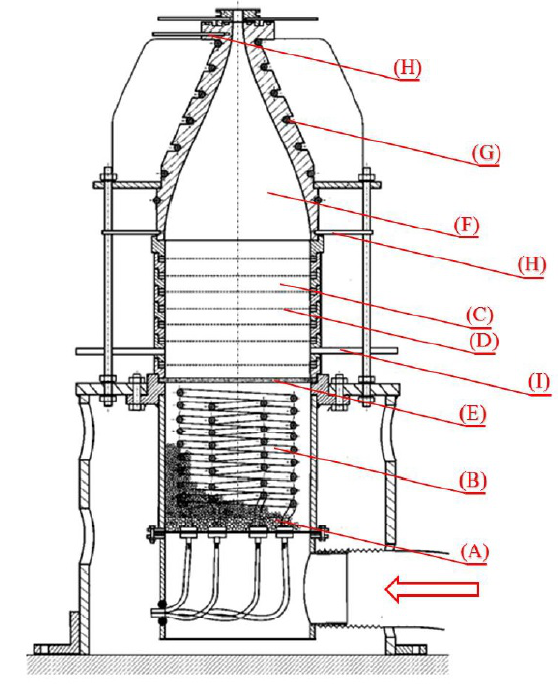
Figure 1. Sketch of the experimental